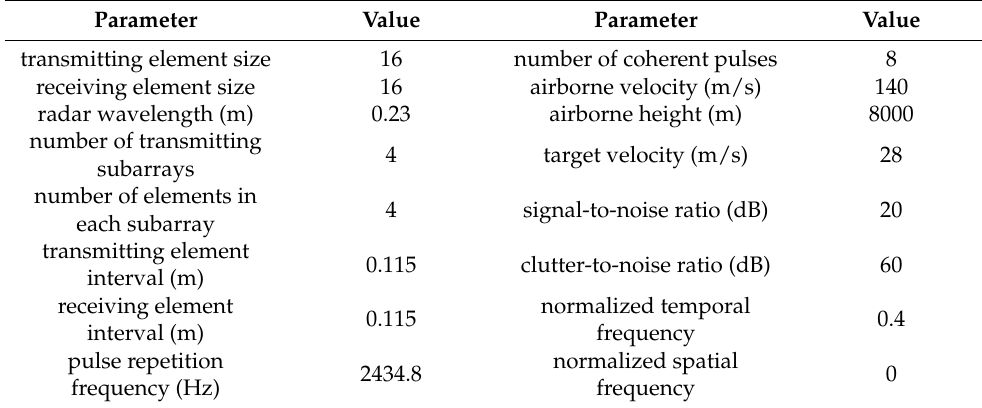
Table 1. Simulation parameters based on airborne active